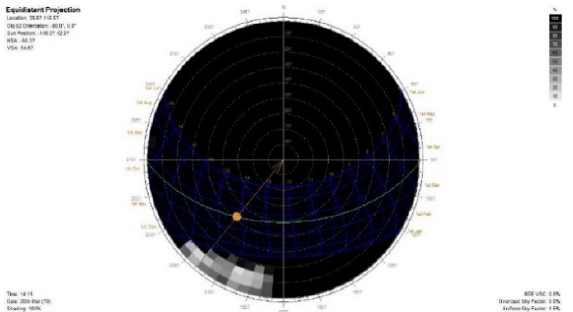
Figure 10: Annual solar shading percentage sun-path diagram at east painting